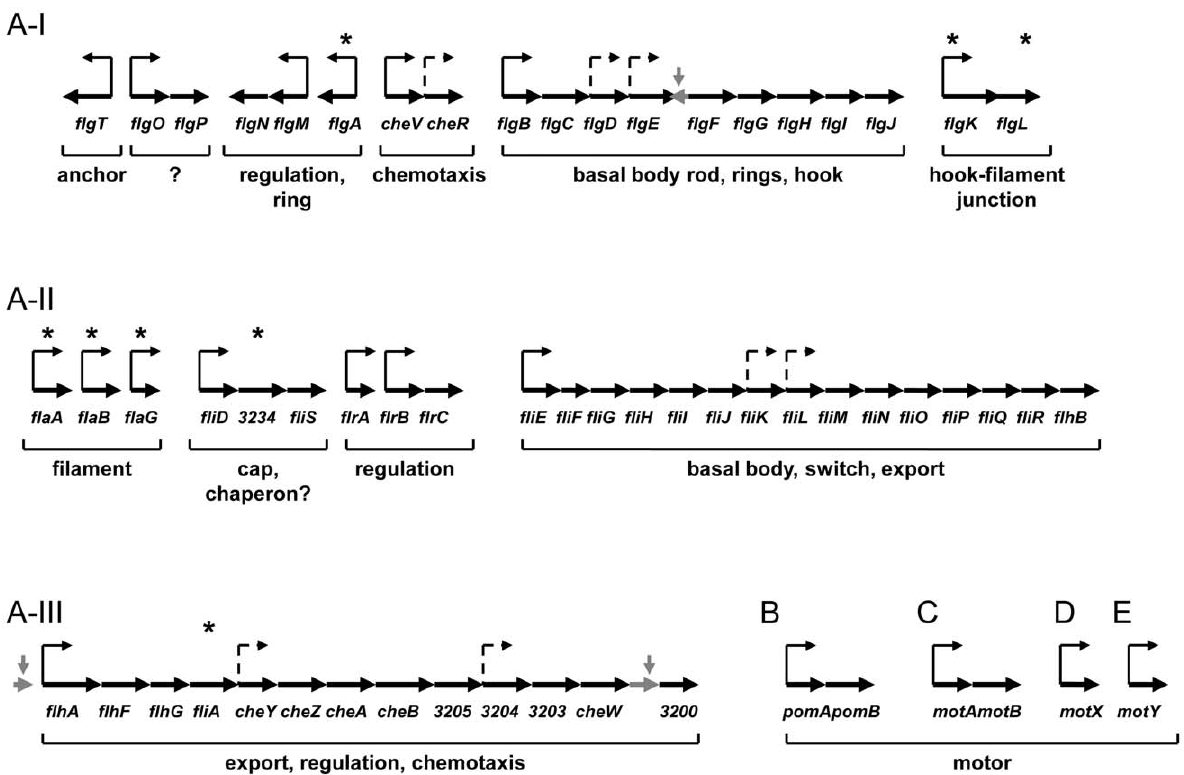
Figure 1. The S.oneidensis flagellar genes. The S. oneidensis genome containsone major regionfor flagellar genes (labelled A) as well as scattered motor genes ( pomAB ( SO1529 - 30 ), motAB ( SO4287 - 6 ), motX ( SO3936 ), and motY ( SO2754 ). Region A, divided into three clusters I, II, III, encompassesgenes SO3200-58 . Thick arrows denote ORFs (not drawn to scale) with corresponding genes below. Genes with an asterisk above were subjected to the physiological analyses in this study. Putative promoters are designated by thin arrows based on operon structures predicted at two sites (http://www.microbesonline.org; http://biocyc.org/SONE211586/). Solid and dash lines represent ones identified at both sites and ones found at only either site, respectively. Pseudogenes removed from the genome are in light